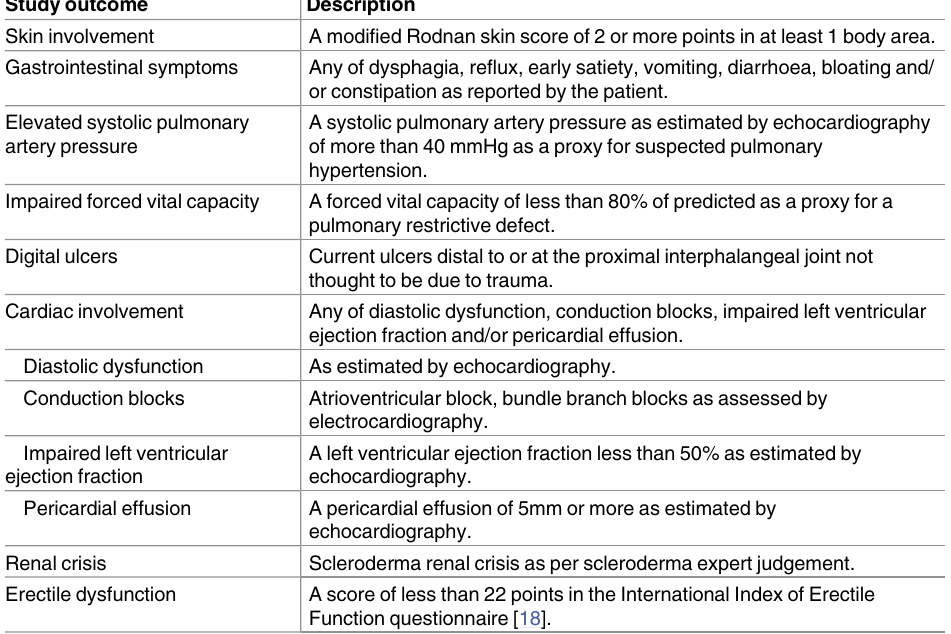
Table 1. Definitions of study